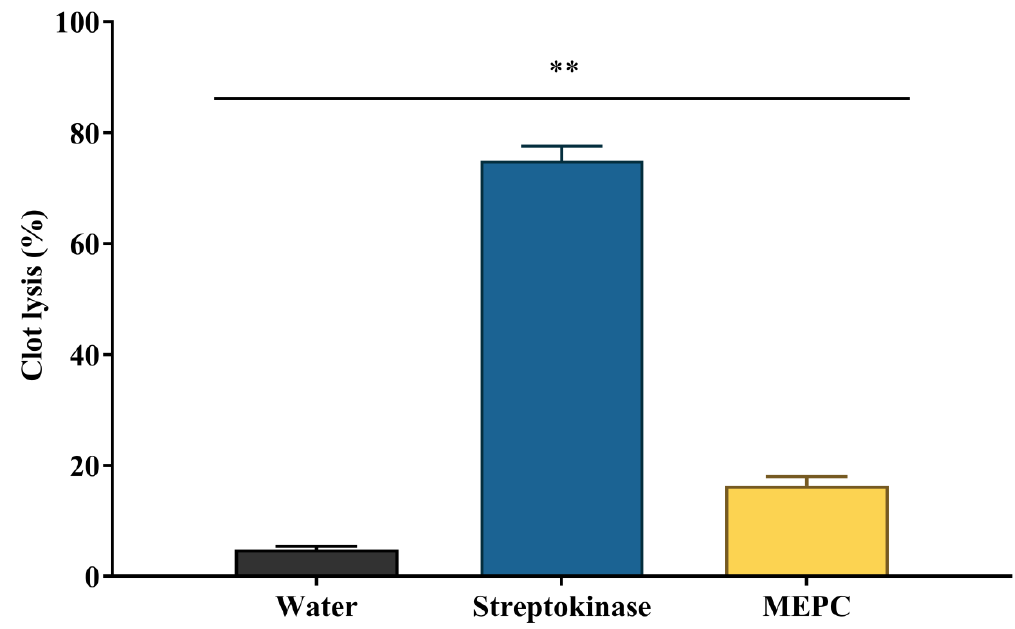
Figure 7. Thrombolytic activity of methanol extract of P. calocarpa (MEPC) and streptokinase in comparison with the water. Values represented as mean ± SEM ( n = 10). ** p < 0.001 considered as significantly di ff erent from the control (Dunnett’s test).